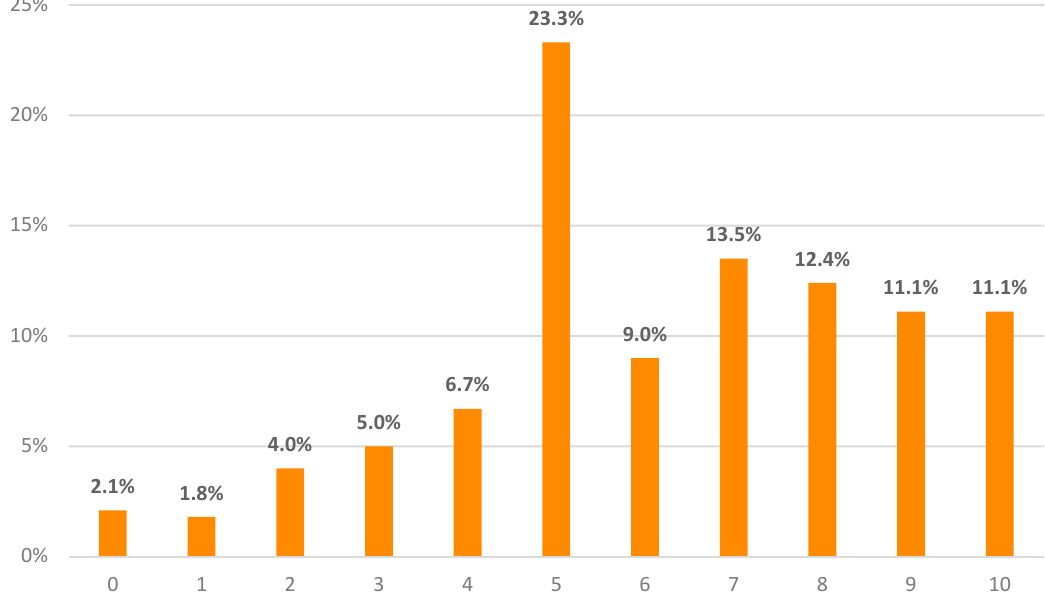
8 of 16 Figure 4. Self-assessment of the improvement in knowledge of remote-sensing data (RSD) as a result of participation in the ARSET program. Values indicate the percentage of respondents who selected each option. In the 11-point scale used, 0 = did not change, and 10 = improved a great deal ( N = 933). Participants improved their knowledge of remote sensing regardless of their prior degree of expertise with RSD. There were no statistically significant differences when comparing respondents according to their prior expertise in remote sensing, X 2 (3, N = 933) = 2.62, p = 0.456. We believe this is a result of ARSET’s gradual learning approach and delivery of both basic and advanced training, which enables participants to improve their skills regardless of their prior knowledge of remote sensing. A US federal government employee who participated in a 2016 training on forest cover and change assessment for carbon monitoring wrote, “[ARSET] training builds my awareness of tools and datasets relevant to the issues my workgroup addresses and, thus, helps us leverage external support and expertise to utilize these tools and data in service of our projects and organizational mission” (Written survey comment, May 2017).